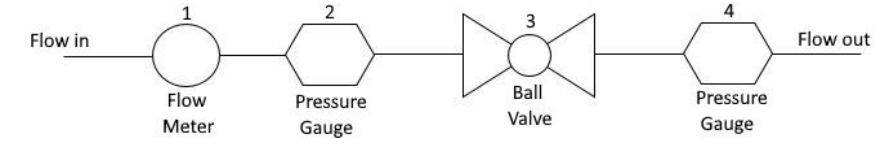
Figure 4: Schematic diagram of the experiment